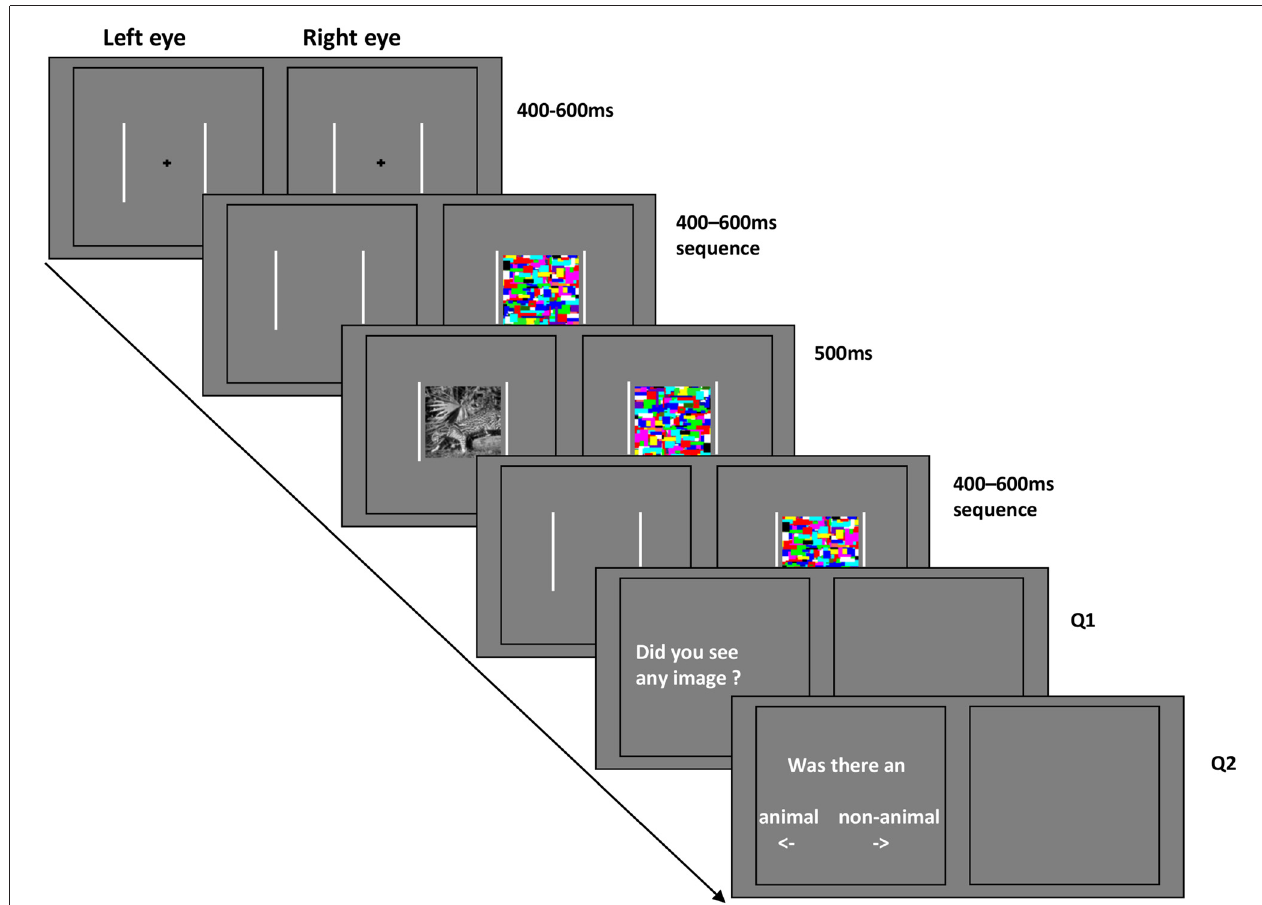
FIGURE 2 | Schematic representation of the continuous flash suppression (CFS) paradigm in Experiment 1 and 2.